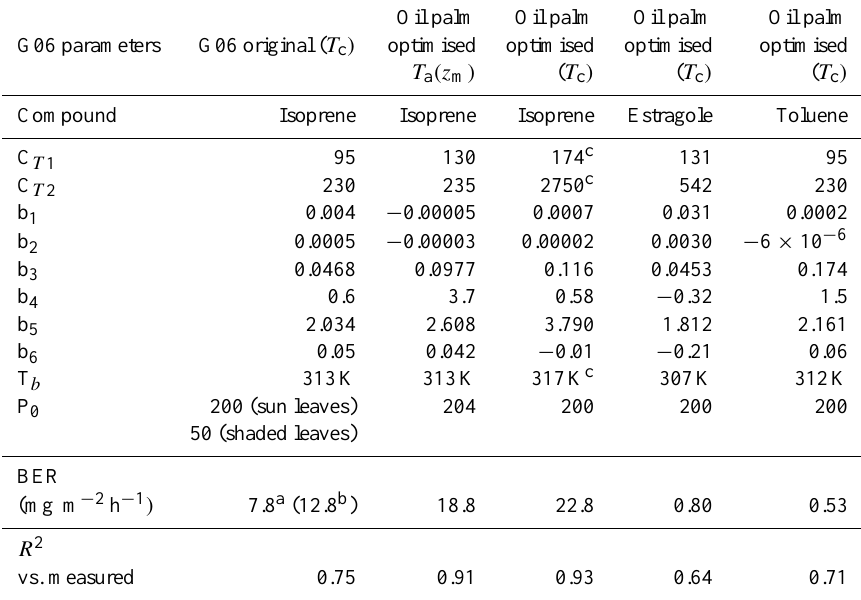
Fig. 7. Exponential relationships between temperature and isoprene mixing ratios (a) , and fluxes (b) , coloured according to magnitude of PAR. Table 3. Comparison of parameters from G06 for isoprene, estragole, and toluene. Parameterisations of toluene are discussed in Sect. 3.5.2. Values for estragole were taken from Misztal et al. (2010). Oil palm Oil palm Oil palm Oil